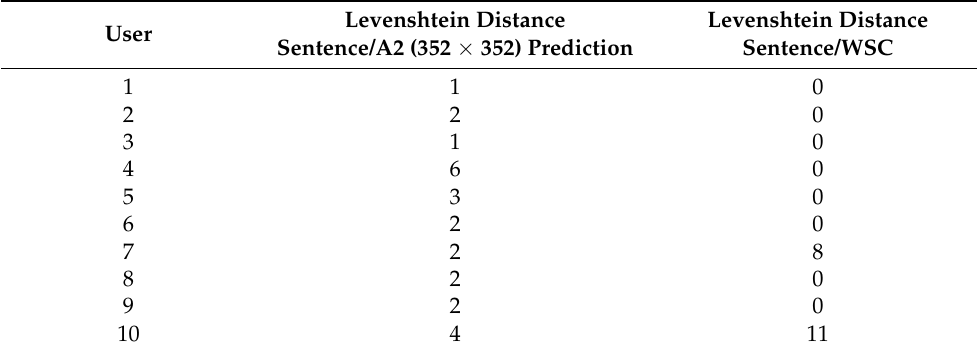
Table 5. Levenshtein distance between sentence and A2 (352 × 352) prediction and sentence and word spelling correction (WSC)